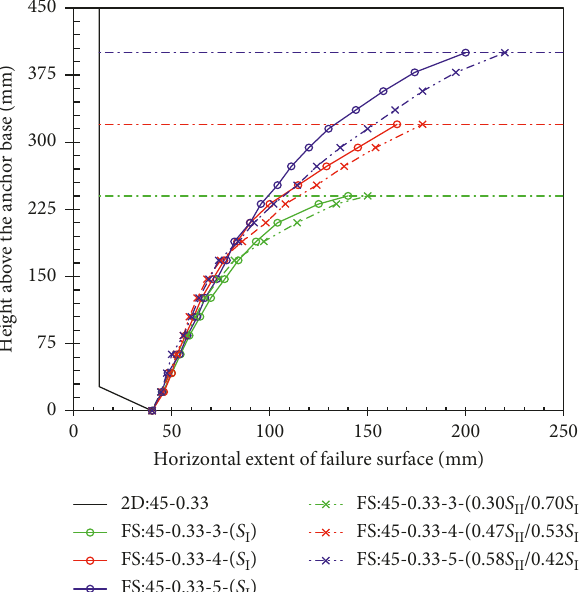
Figure 7: Comparison of FS:45-0.33-3-( S